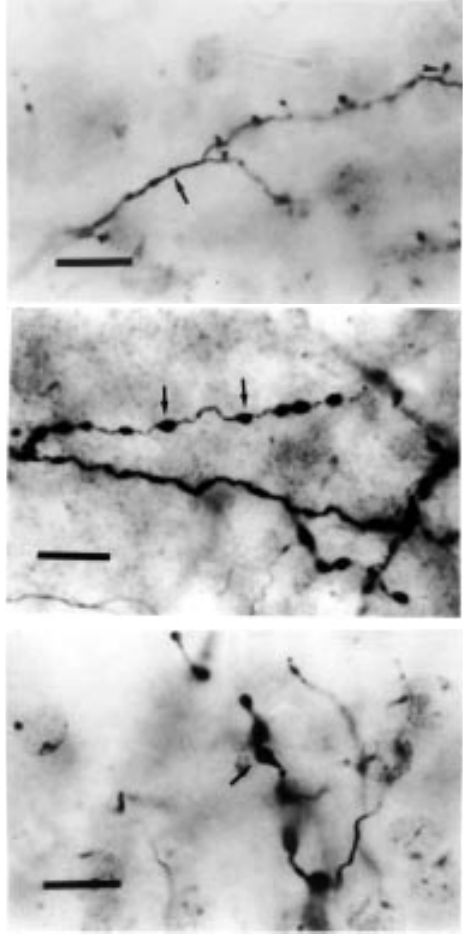
Figure 7 - High power photomicrographs illustrating “en passant” and “terminaux” boutons for different axon terminals. Top , Type Ia axon; middle , type Ib axon; bottom , type II axon. Arrows point to “en passant” boutons. Arrowhead points to “terminaux” bouton. Scale bars = 100 µm.